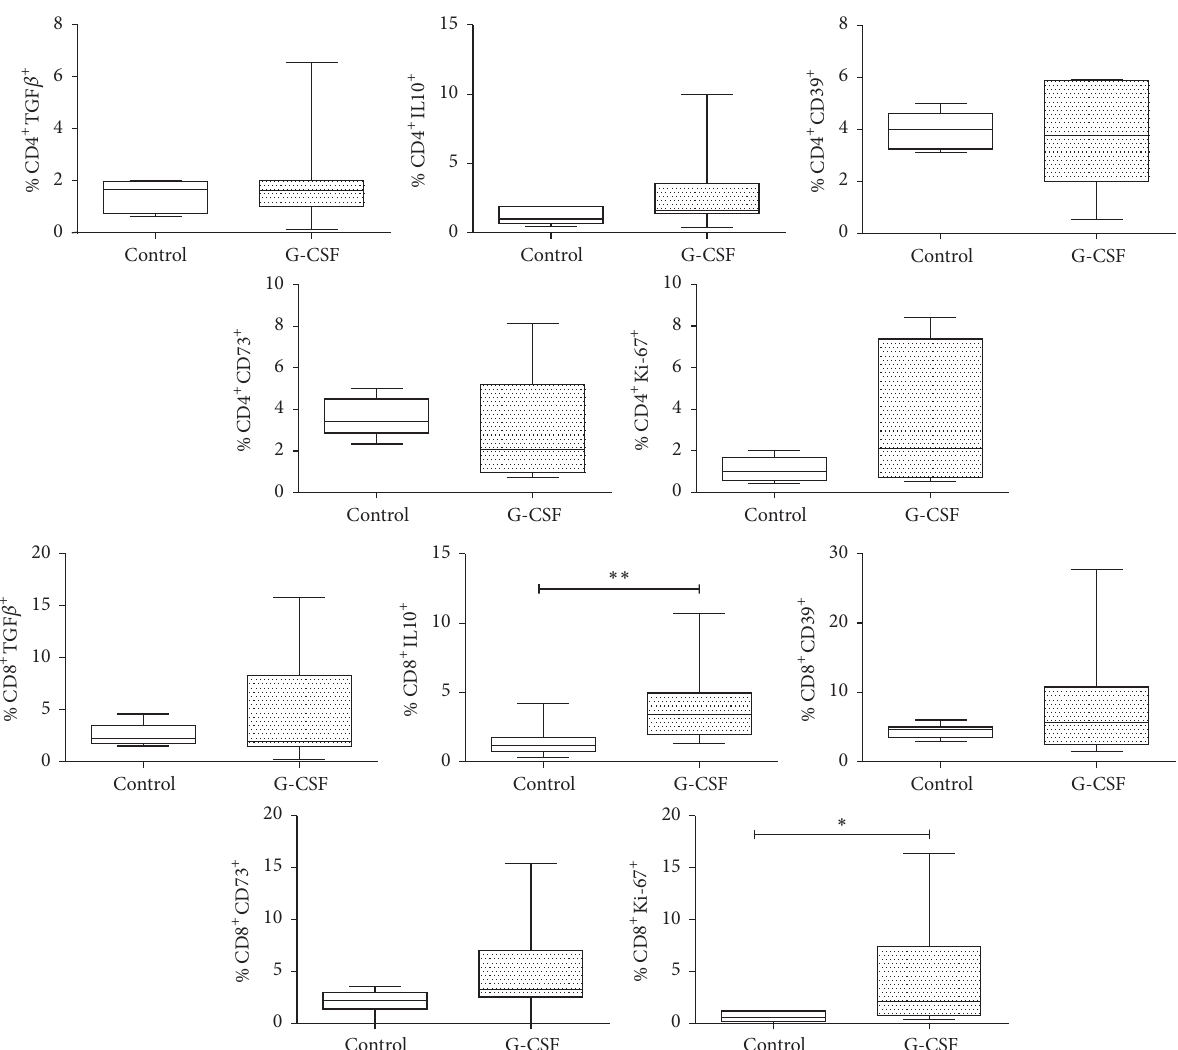
Figure 3: Cell viability and anti-inflammatory molecules in healthy donors mobilized with G-CSF. Determination of TGF 𝛽 , IL-10, CD39, CD73, and Ki-67 in peripheral blood CD4 + and CD8 + cells from a control group ( 𝑛 = 6 ) and a group of G-CSF-mobilized donors ( 𝑛 = 8 ). Box plots show population distribution and whiskers denote one standard deviation. A significant increase is observed in the number of CD8 + IL-10 + and CD8+Ki67 + cells; the change in CD8 + CD73 + cells is not significant, but a marked tendency to increase is shown ( 𝑝 = 0.06 ); no changes or tendencies are seen in marker expression in CD4 + cells. ∗ 𝑝 < 0.05 ; ∗∗ 𝑝 < 0.01